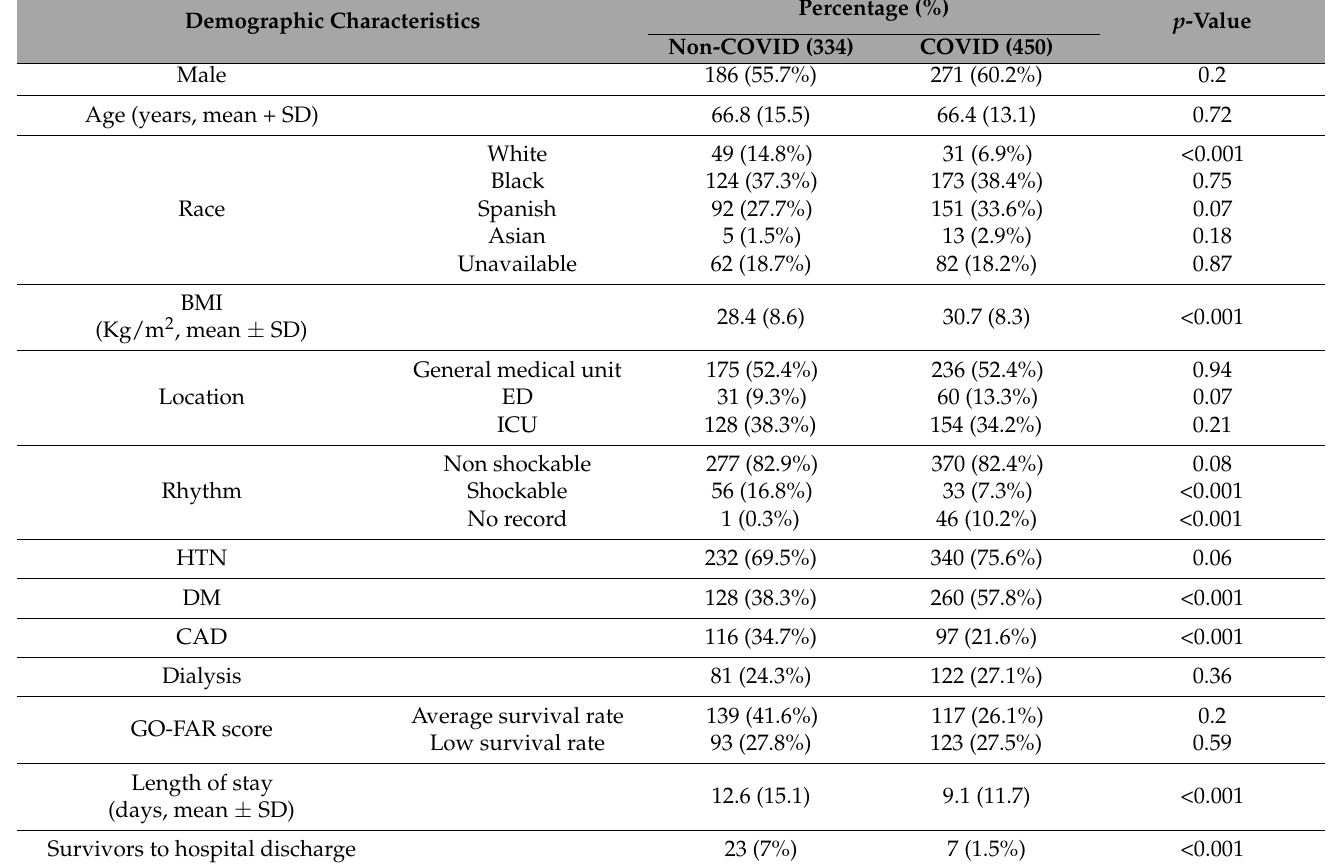
Table 2. Characteristics of COVID patients compared to non-COVID patients. Demographic